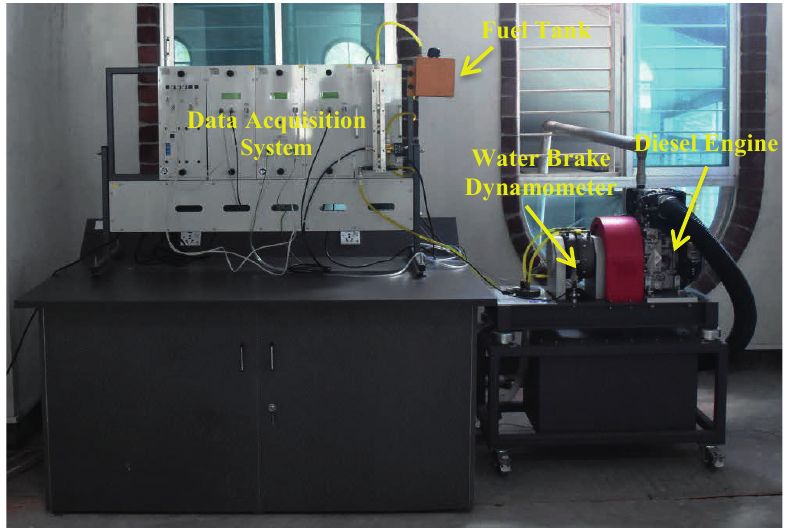
Fig. 7. The single-cylinder CI engine with water brake dynamometer and data acquisition system. Comparison of Engine Performance Characteristics